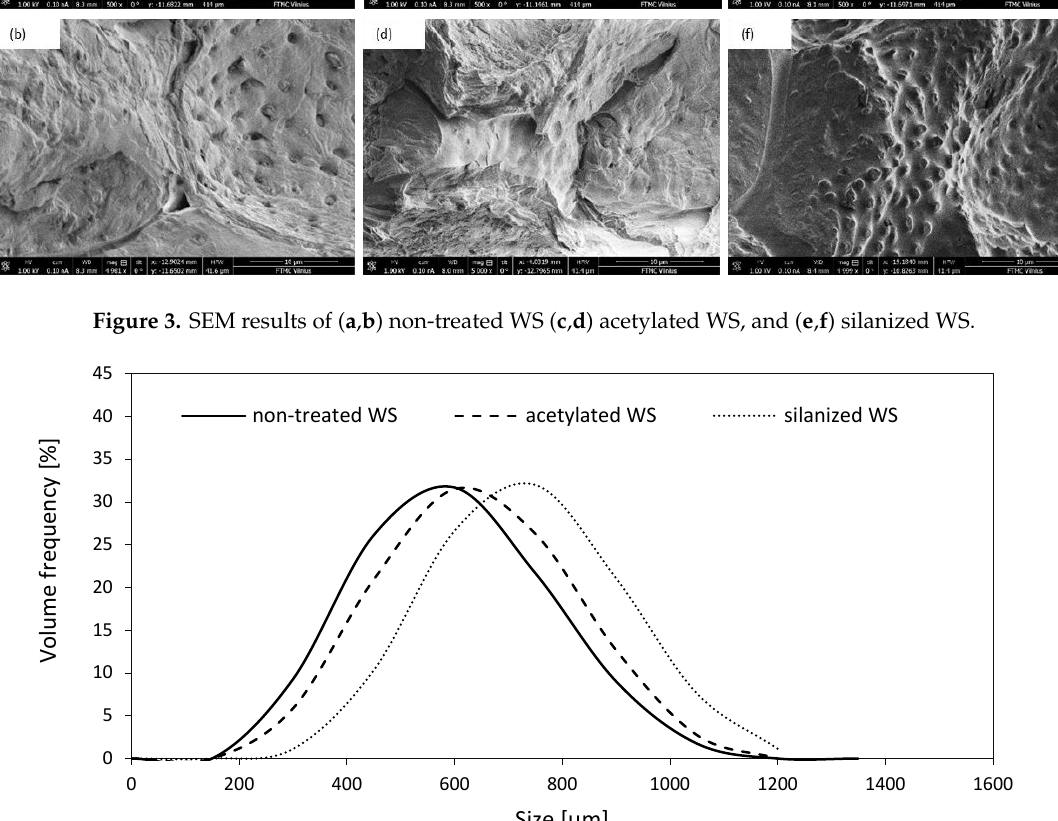
Figure 3. SEM results of ( a , b ) non-treated WS ( c , d ) acetylated WS, and ( e , f ) silanized WS.